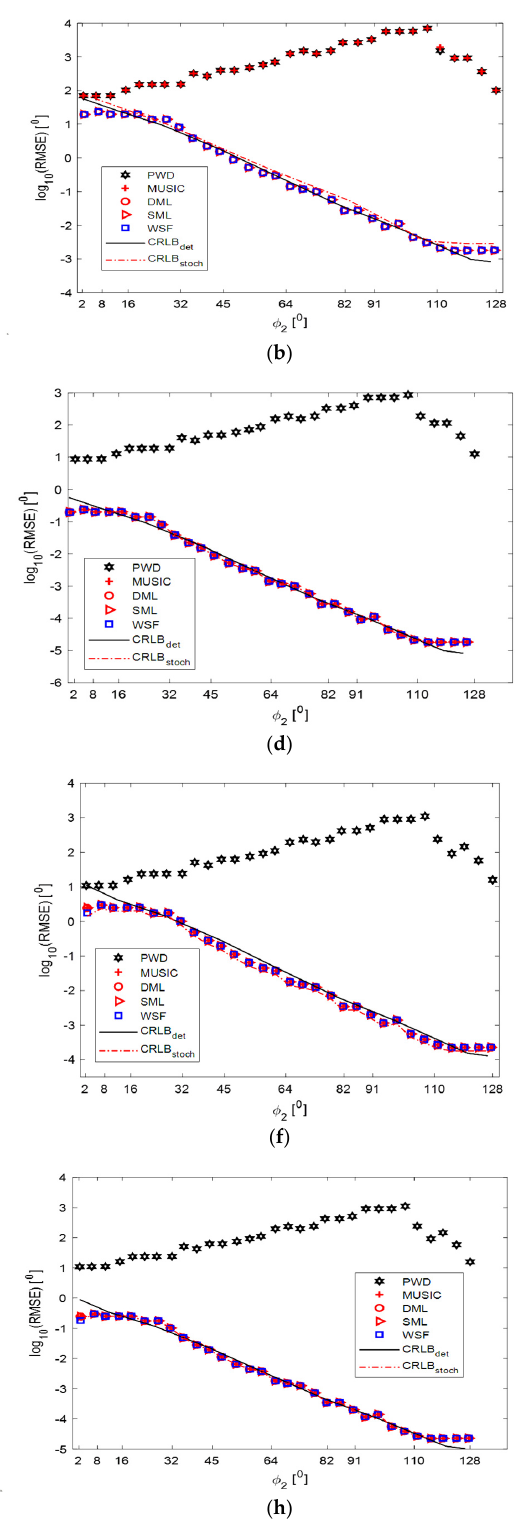
Figure 4. Monte Carlo samples against φ 2 when SNR = 20 dB and the second signal is delayed by d samples. ( a ) ˆ φ 1 , d = 0 ( b ) ˆ φ 2 , d = 0 ( c ) ˆ φ 1 d = 0.5 ( d ) ˆ φ 2 , d = 0.5 ( e ) ˆ φ 1 , d = 1 ( f ) ˆ φ 2 , d = 1 ( g ) ˆ φ 1 , d = 8 ( h ) ˆ φ 2 , d =